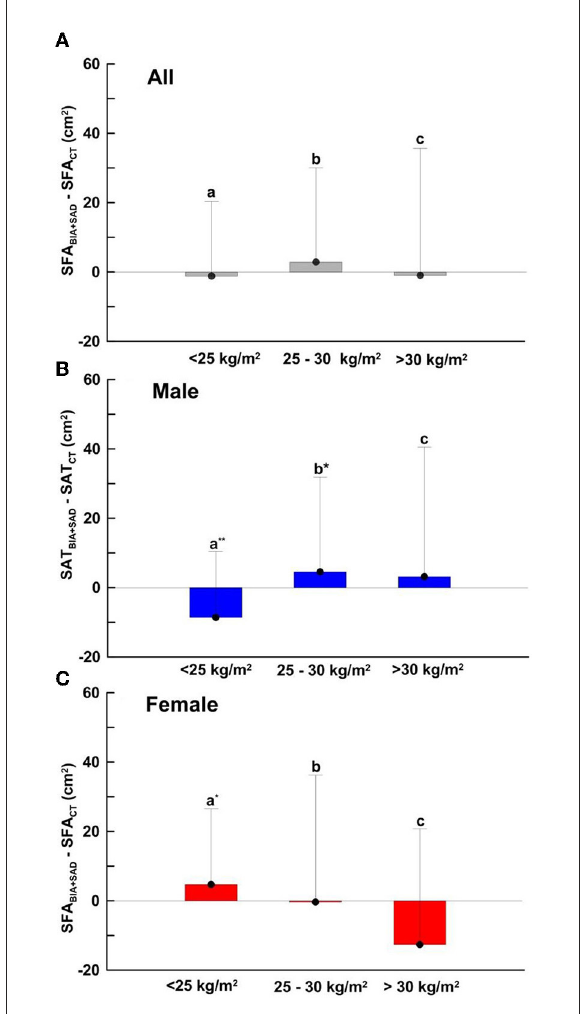
FIGURE4 SFA-dependent bias of SFA BIA + SAD compared with SFA CT in (A) total ( n = 520), BMI < 25 kg/m 2 , n = 154; 25 kg/m 2 ≤ BMI > 30 kg/m 2 , n = 275; BMI > 30 kg/m 2 , n = 104 (B) male ( n = 310), BMI < 25 kg/m 2 , n = 67; 25 kg/m 2 ≤ BMI > 30 kg/m 2 , n = 180; BMI > 30 kg/m 2 , n = 62 and (C) female ( n = 210), BMI < 25 kg/m 2 , n = 86; 25 kg/m 2 ≤ BMI > 30 kg/m 2 , n = 96; BMI > 30 kg/m 2 , n = 22. Data are presented as the mean difference ± SD. Means with symbol are significantly different, p < 0.05( * ), p < 0.01( **